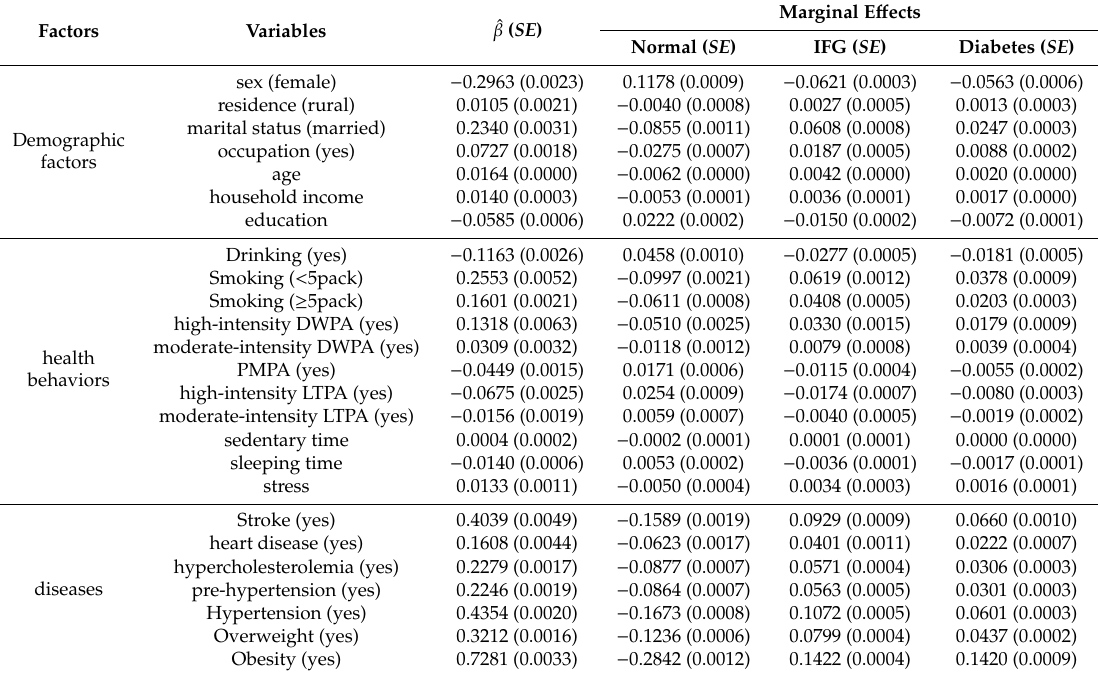
Table 4. Estimates of marginal e ff